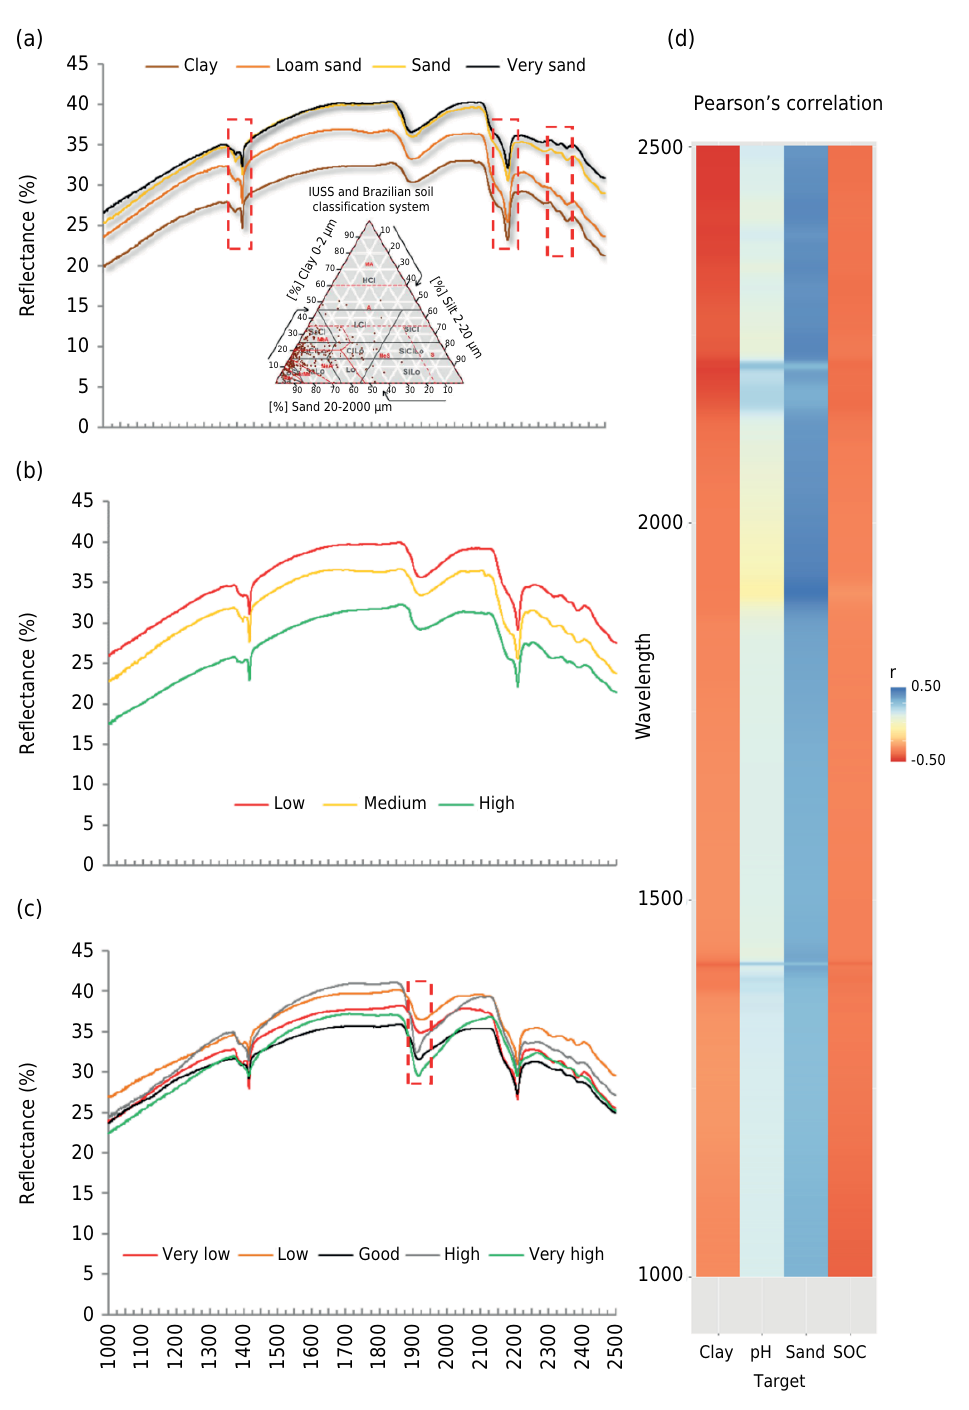
Figure 3. Median of spectral curves grouped by clay (a), soil organic carbon (b), and pH(H 2 O) (c) contents. Pearson correlation index between the soil properties and spectral reflectance in the shortwave infrared